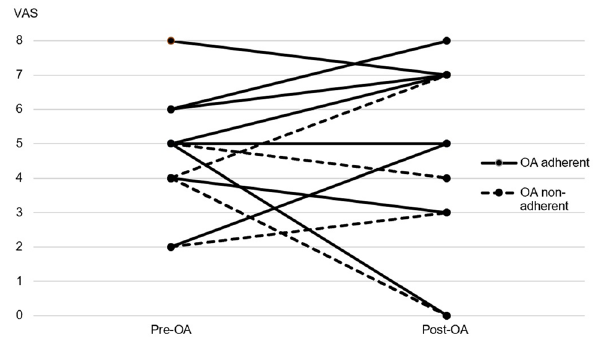
Figure 3. Change in average headache intensity for each individual subject of the oral appliance adherent and non-adherent groups. OA oral appliance. Microsoft PowerPoint 2019 (Microsoft, Redmond, WA, USA). https :// www.micro soft.com/en-ca/micro soft-365/power point